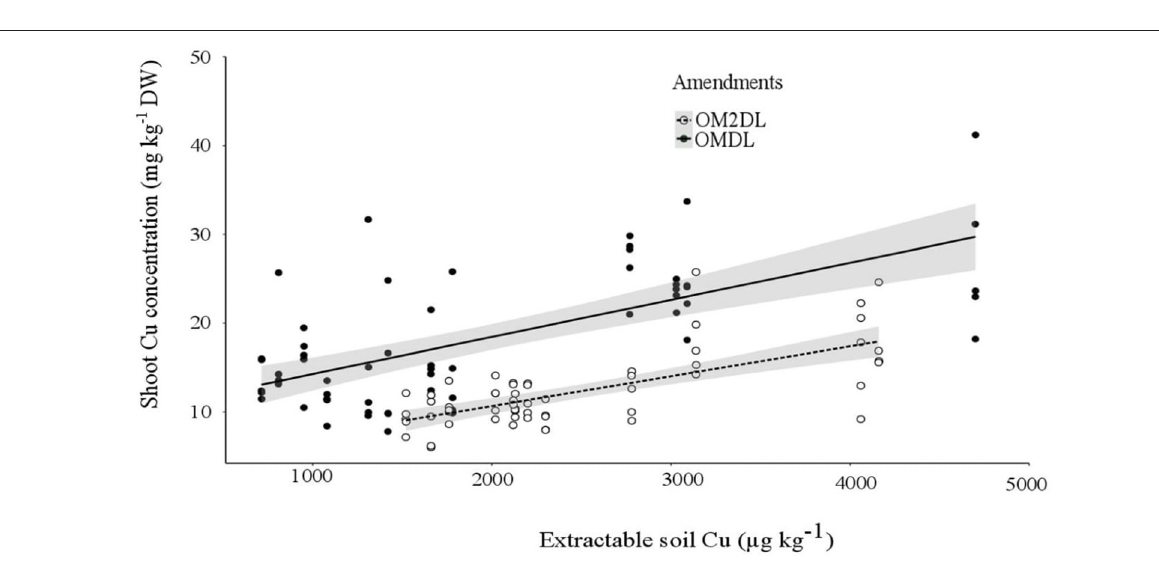
FIGURE 4 | ANCOVA analysis for shoot Cu concentration (mg kg − 1 ) of sunflower plants depending on 1M NH 4 NO 3 -extractable soil Cu (mg Cu kg − 1 ) and soil treatments: OMDL (• and black lines) and OM2DL ( ◦ and dotted lines) ( n = 20